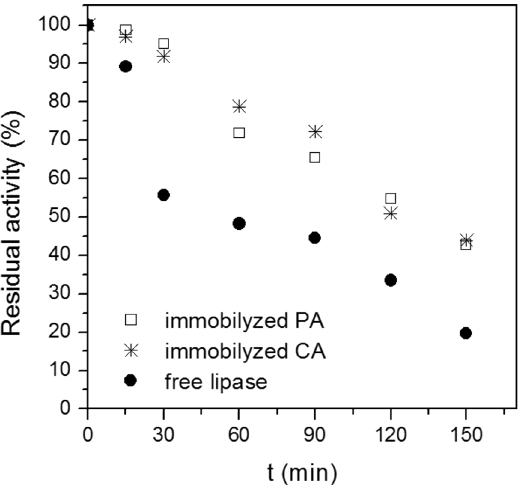
Figure 7. Thermal deactivation for: (square) free lipase, (star) lipase immobilized by physical absorption (PA), and (sphere) lipase immobilized by covalent attachment (CA).